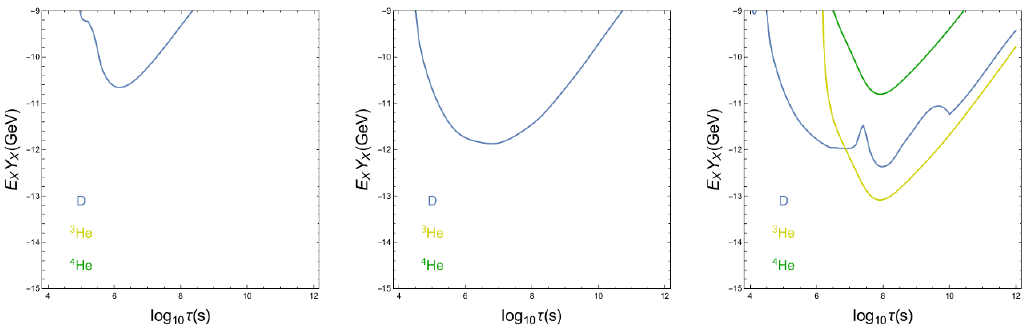
Figure 7 . Same as (cid:12)gure 6 but without FSR e(cid:11)ects.